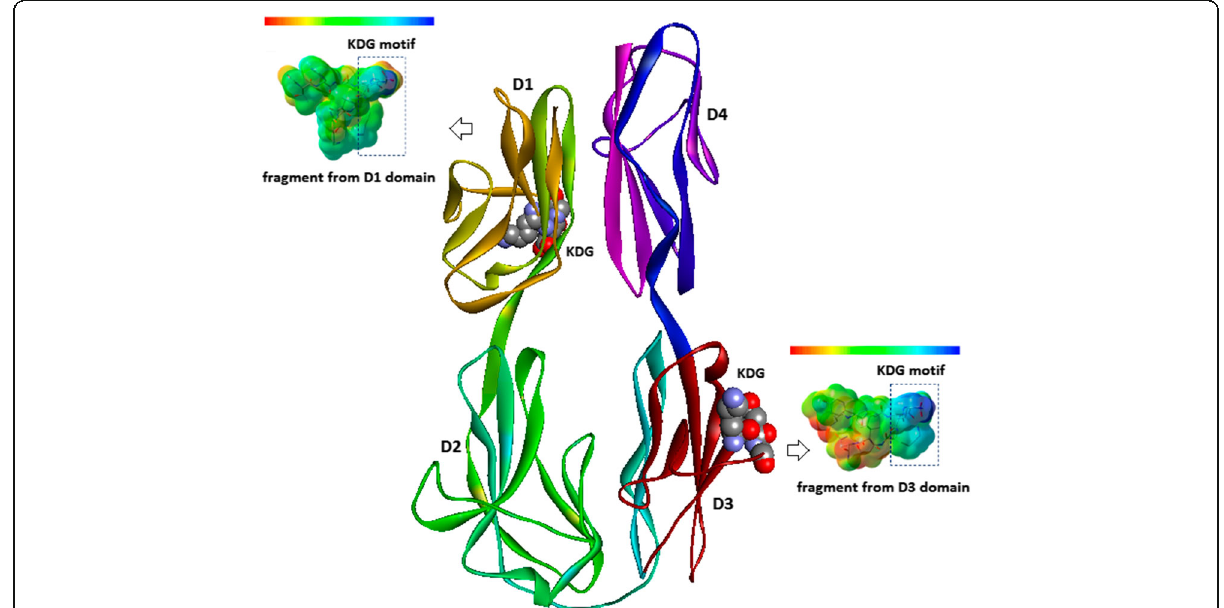
Fig. 1 Losac three-dimensional molecular model shown as solid ribbons indicating the D3 (cell adhesion) and D1 domains. The KDG structural motifs are displayed as CPK or space-filling model (Discovery Studio Visualizer, v.4, Accelrys Software, Inc., 2005-2013). EP maps (B3LYP/3-21G*; Gaussian 03 W, Gaussian, Inc.; GaussView 0.5, Gaussian, Inc.) for the peptide fragments from D3 and D1 domains on the molecular surfaces were calculated, and can be interpreted by a color range from – 0.11 (intense red; higher electronic density distribution) to +0.11 (intense blue; lower electronic density